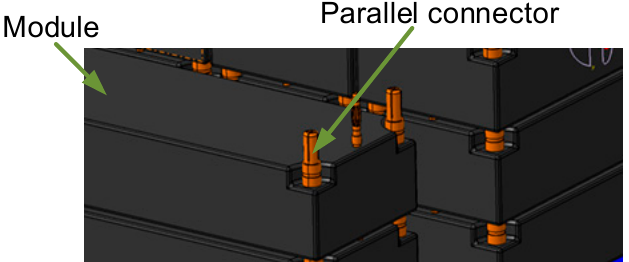
Figure 9. Example of parallel connection. Processes 2020 , 8 , x FOR PEER REVIEW